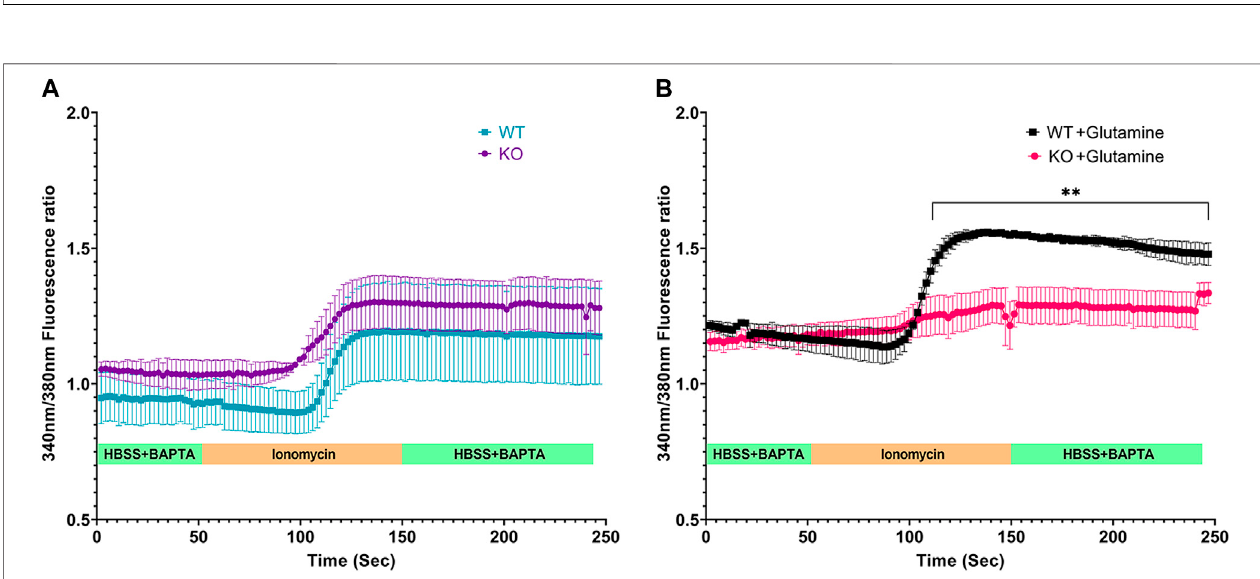
FIGURE4| Calciumef fl uxfrominternalstoresinImmortalizedWTand Slc4a11 KOMCEC. (A) Slc4a11 WTandKOcellswereculturedinmediawithoutglutamine, loaded withFura-2and perfused with Hanks Buffer with BAPTA toestablisha baseline (0 – 50 s), followed by perfusion withionomycin for100 s (B) Slc4a11 WT and KO cellswerecultured inmediawithglutamine.ThecellswereperfusedwithHanksBufferwithBAPTAtoestablishabaseline(0 – 50 s),followedbyperfusion withionomycin for 100 s. Student ’ s t-test. n = 3, ** p < 0.01.